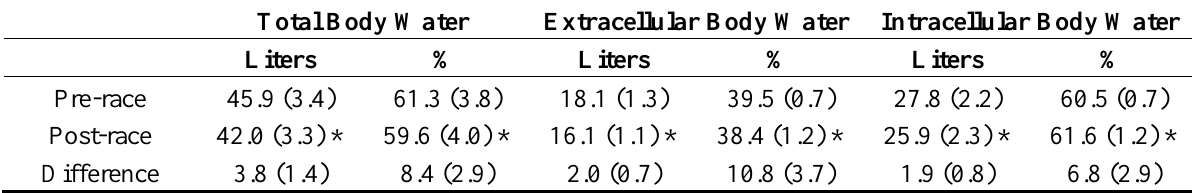
Table 5. Bioimpedance bioelectrical